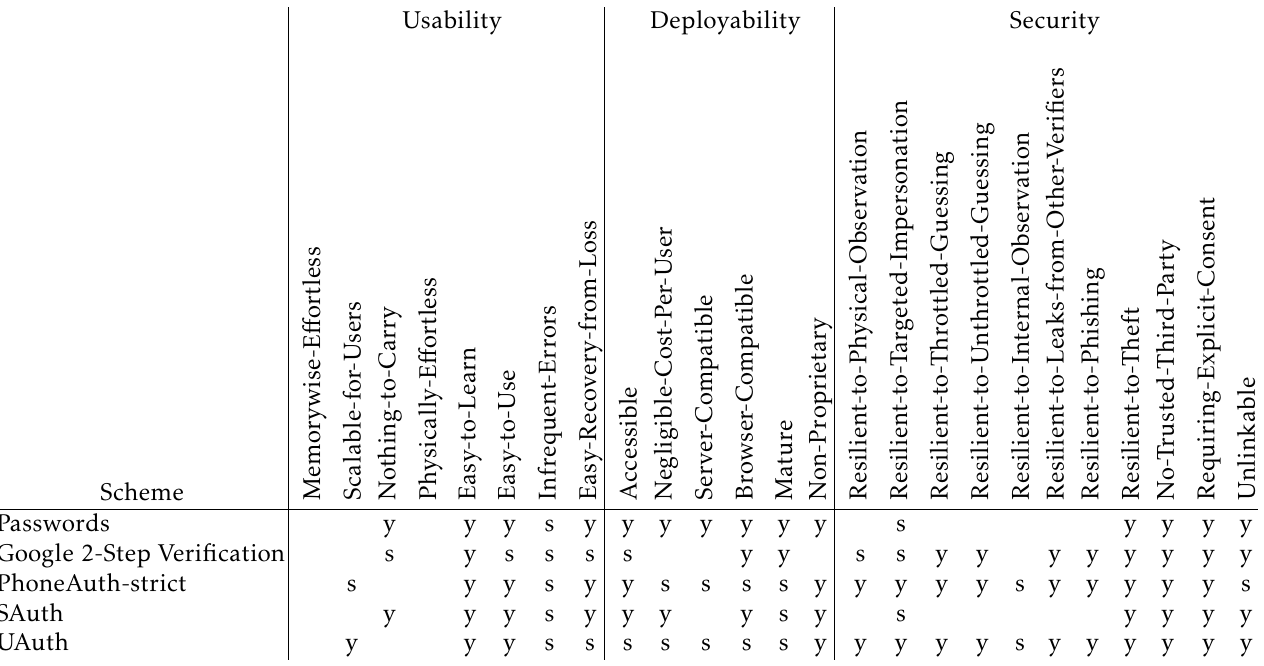
Table 1. Comparison of UAuth against password, Google 2-step Verification, PhoneAuth and SAuth using Bonneau et al.’s evaluation framework. ’y’ means the benefit is provided, ’s’ means the benefit is somewhat provided, while blank means the benefit is not provided